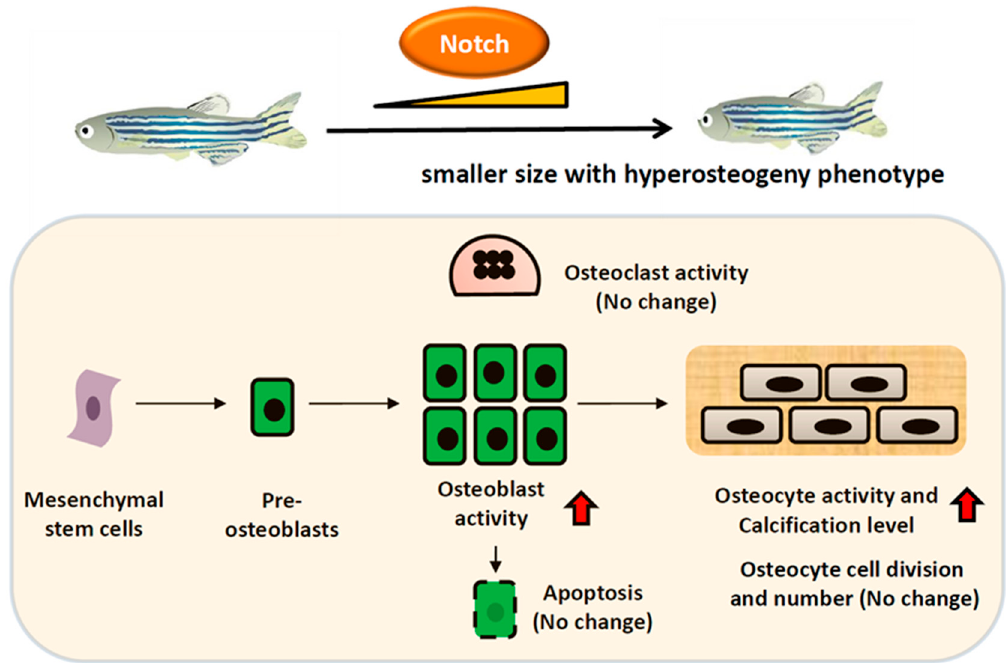
Figure 9. Schematic presentation of the effect of Notch activation on osteoblast. Increasing Notch expression results in the activation of osteoblasts which may differentiate into osteocytes that are embedded in the mineralized matrix to enhance bone density. On the contrary, the osteocyte number and osteoclast activity didn’t display significant alteration in Tg(Ola.Sp7:N1aICD) cy31 .